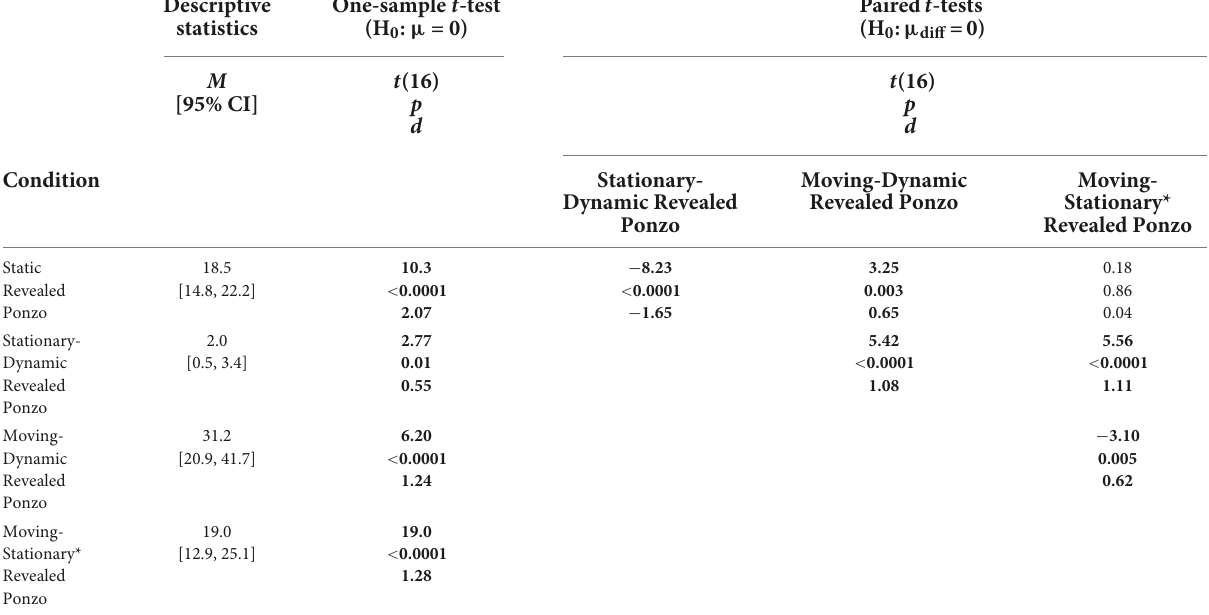
TABLE 5 One-sample and pairwise paired t -tests for all conditions with surrounding context of Experiment 5. Descriptive